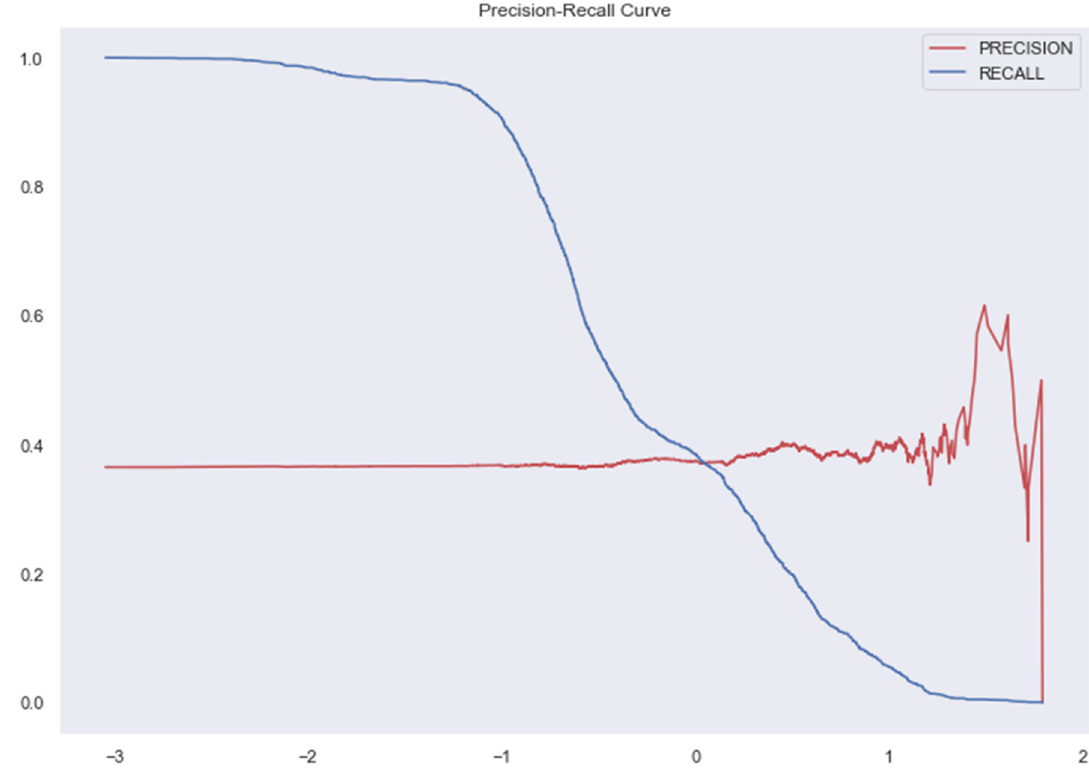
Figure 9. AUC and Precision-Recall Curve for SVM.